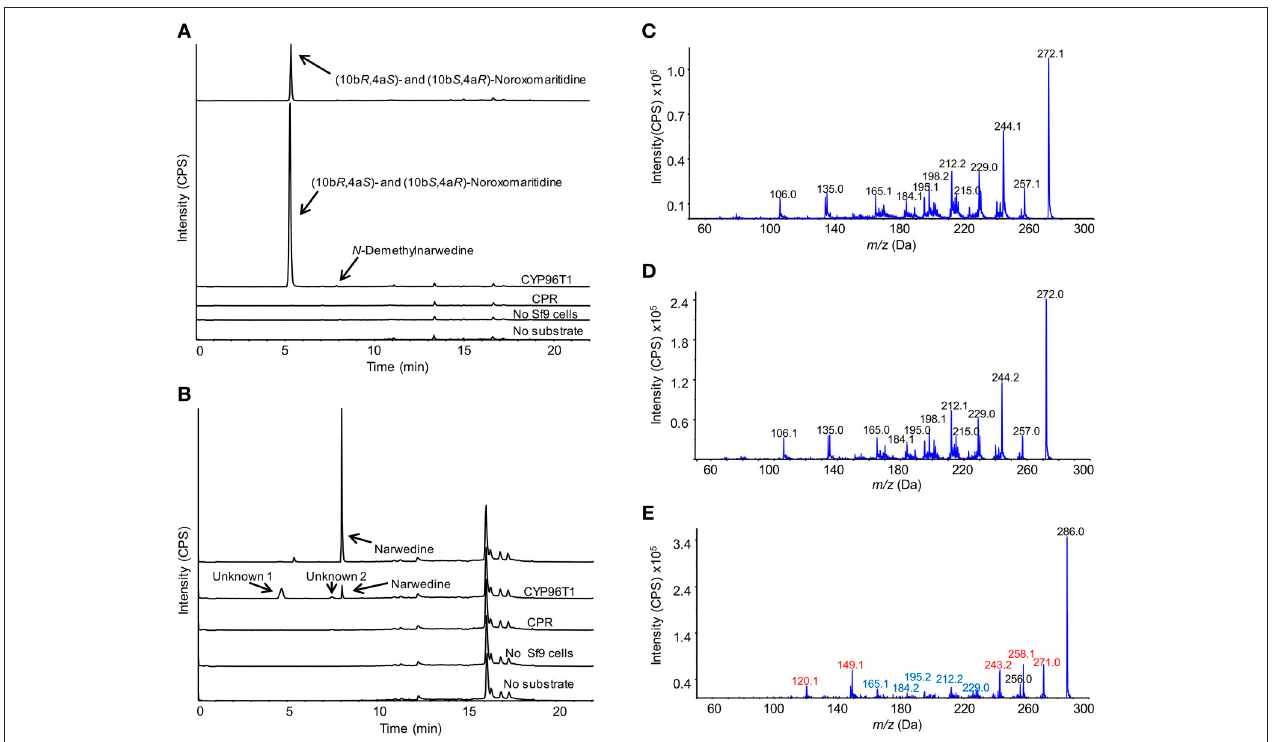
FIGURE 5 | LC-MS/MS enhanced product ion scan (EPI) monitoring the C-C phenol coupling of 4 ′ - O -methylnorbelladine and 4 ′ - O -methyl- N -methylnorbelladine in CYP96T1 assays. Arrows indicate peaks unique to Sf9 cell containing assays with substrate present. (A) Standards and assays with 4 ′ - O -methylnorbelladine as the substrate. Sample runs top to bottom (10b R ,4a S )- and (10b S ,4a R )-noroxomaritidine standard (1 µ M), CYP96T1 assay, CPR assay, assay without Sf9 cells, and CYP96T1 assay without 4 ′ - O- methylnorbelladine. (B) Standards and assays with 4 ′ - O -methyl- N -methylnorbelladine as the substrate. Top to bottom narwedine standard, CYP96T1 assay, CPR assay, assay without Sf9 cells, and assay without 4 ′ - O- methylnorbelladine. (C) EPI of the (10b R ,4a S )- and (10b S ,4a R )-noroxomaritidine standard. (D) EPI of the CYP96T1 (10b R ,4a S )- and (10b S ,4a R )-noroxomaritidine product with 4 ′ - O